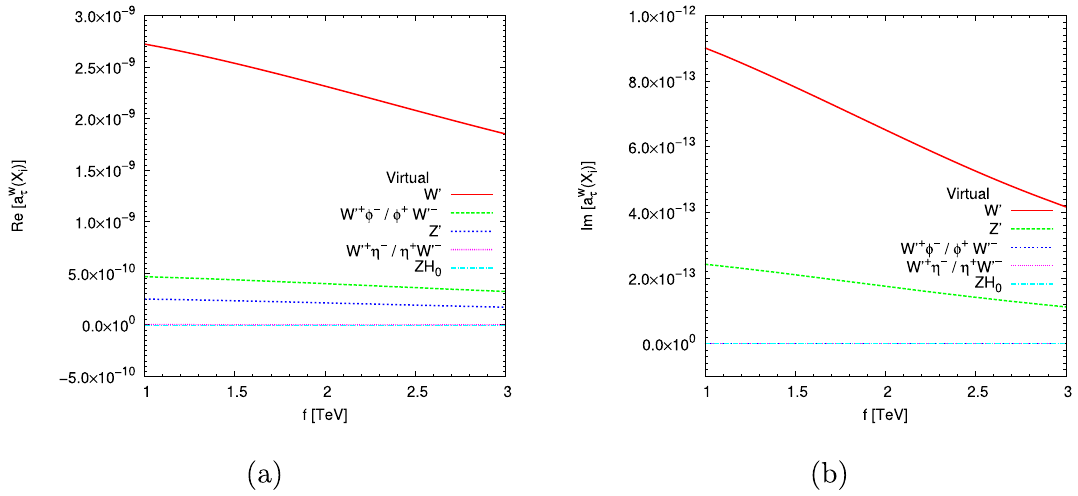
Fig. 8 Individual vector and scalar–vector contributions to a W τ . a Re( a W τ ). b Im( a W τ ). The plots are obtained with the fixed value of F = 4000 GeV. The values provided in Table 3 are used for the remaining model